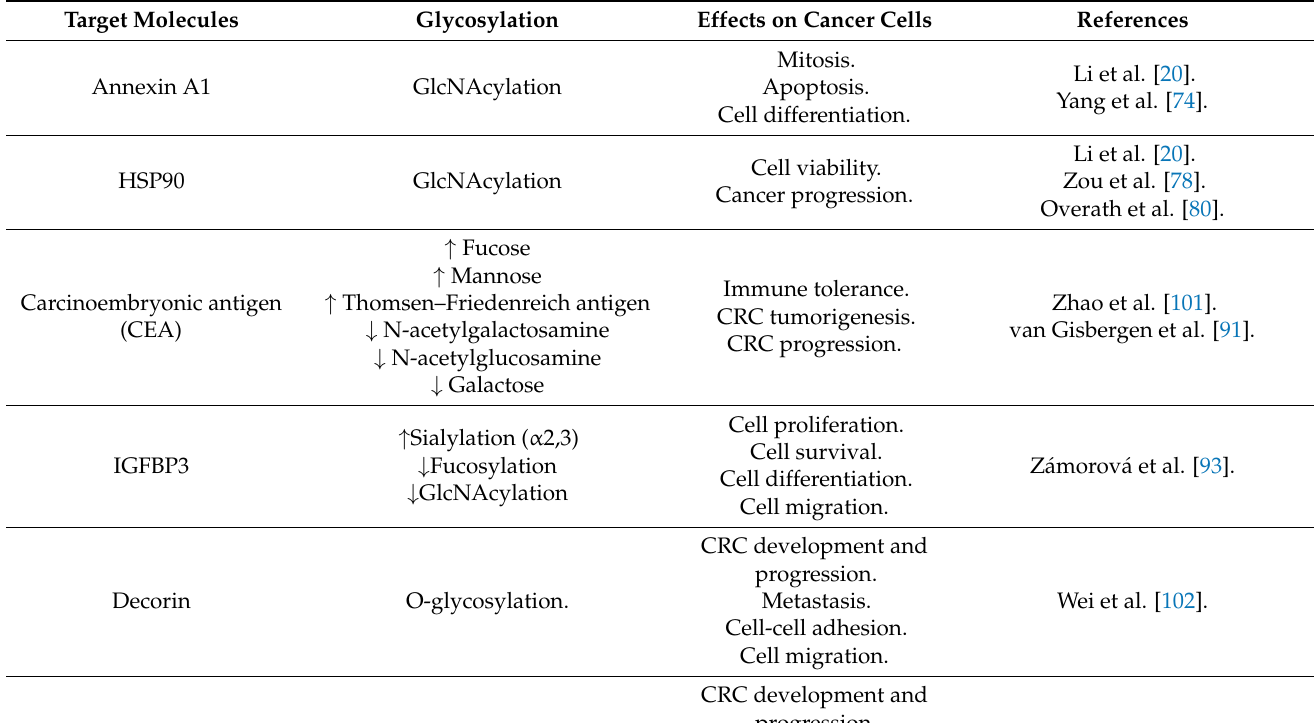
Table 2. Summary of molecules identified to be glycosylated in colorectal cancer samples. Glycosylation and associated biological effects on cancer cells have been